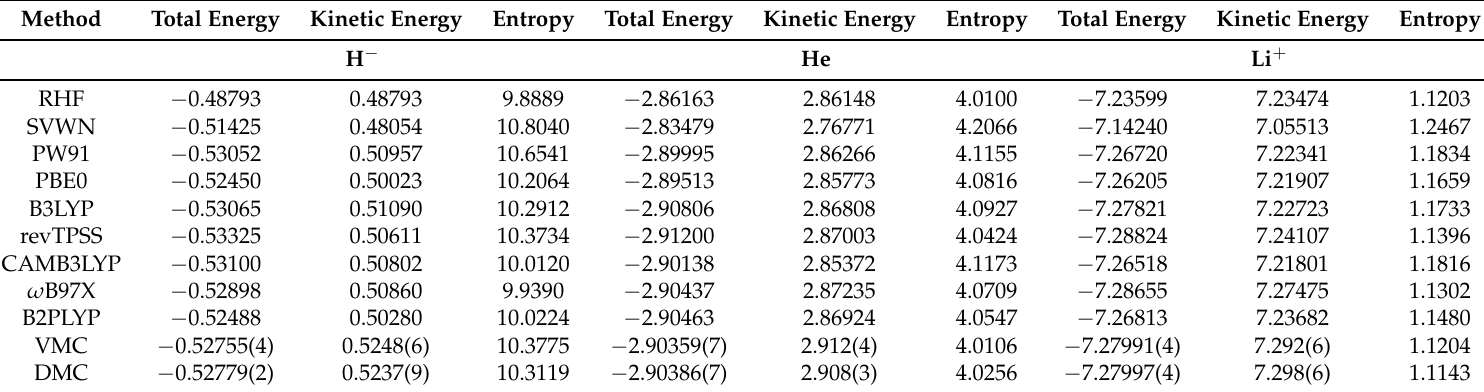
Table 1. Total energy, kinetic energy, and Shannon entropy for some atomic systems of the He-like series calculated at different level of computation. Data are in atomic units (a.u.).